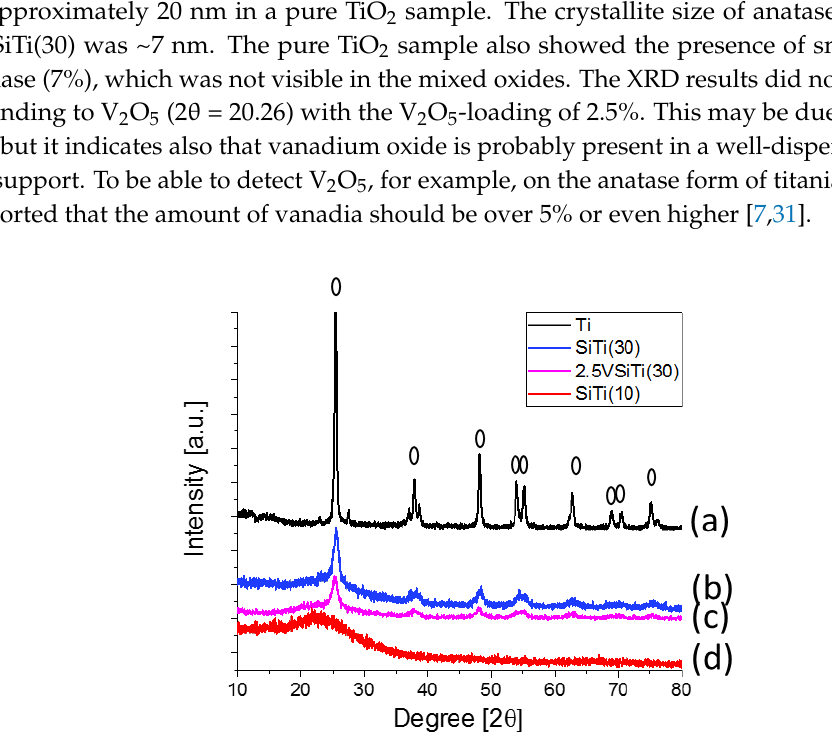
Figure 1. XRD patterns of the SiO 2 -TiO 2 catalyst with different ratios of silica and titania (calcined at 500 °C): ( a ) Ti; ( b ) SiTi(30); ( c ) 2.5V/SiTi(30); ( d ) SiTi(10).